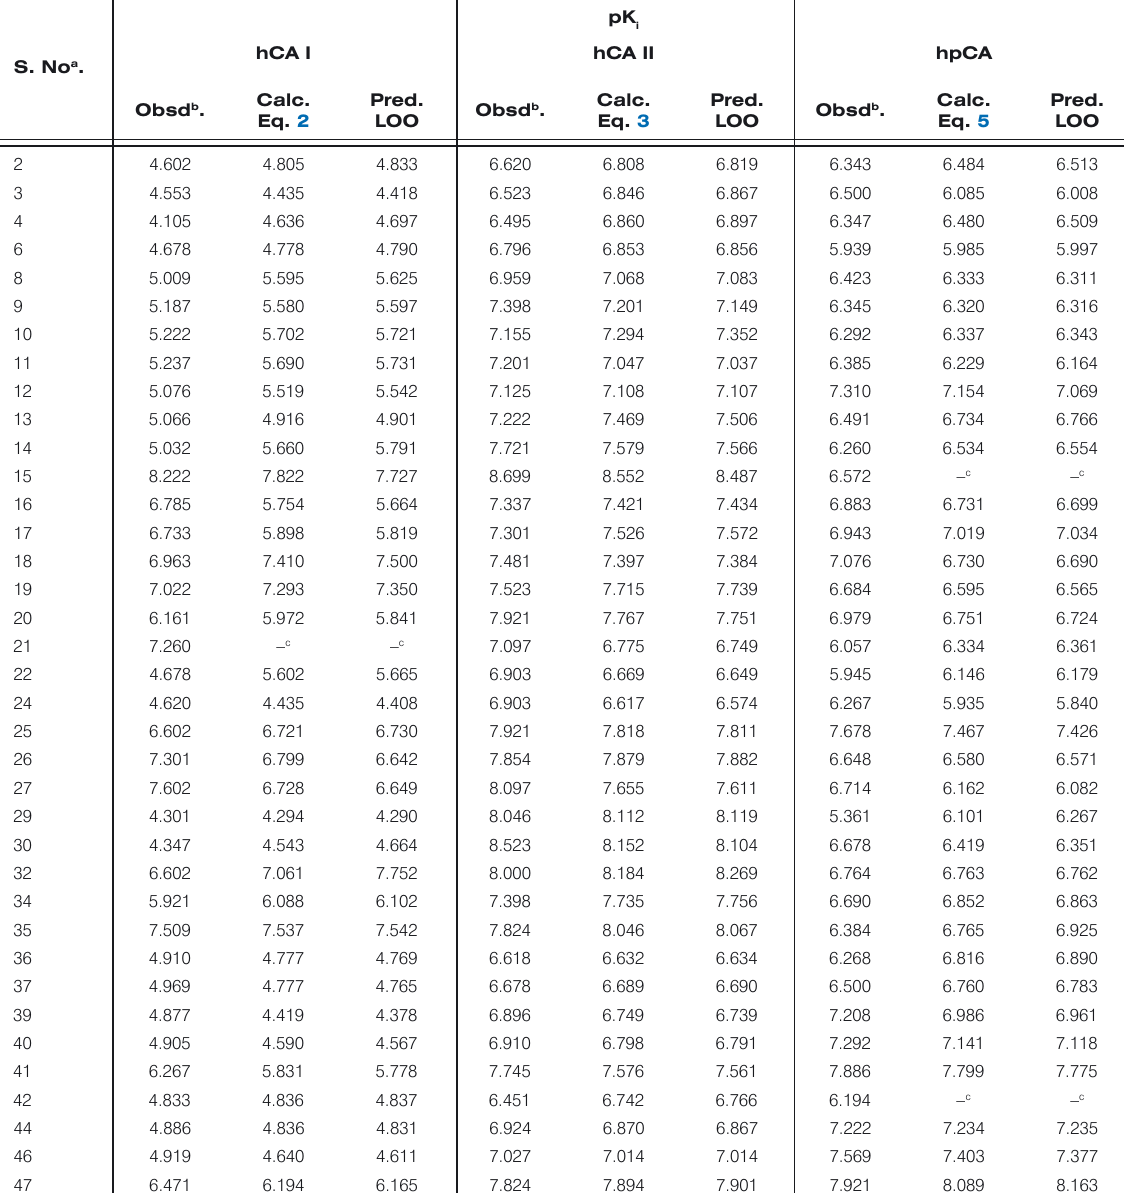
Table 1. Observed and modeled carbonic anhydrase inhibition activities of training set compounds.